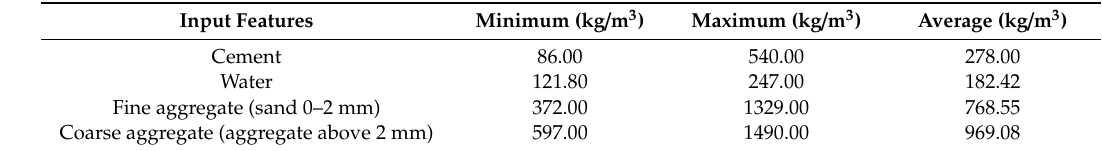
Table 2. Ranges of input features of database input